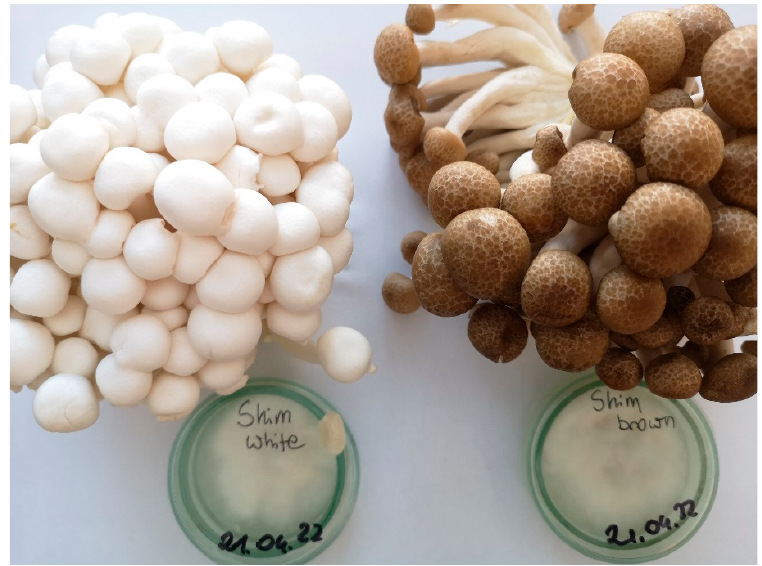
Figure 3. Fruiting bodies and mycelia on a solid medium of H. marmoreus white and brown varieties (photo by Katarzyna Ka ł a).